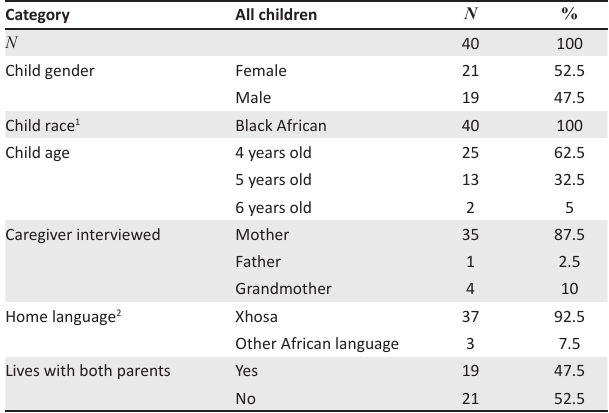
TABLE 2: Caregiver